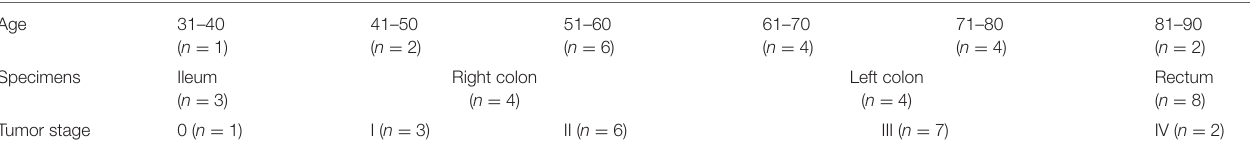
TABLE 1 | Demographic and clinical data of patients underwent colorectal